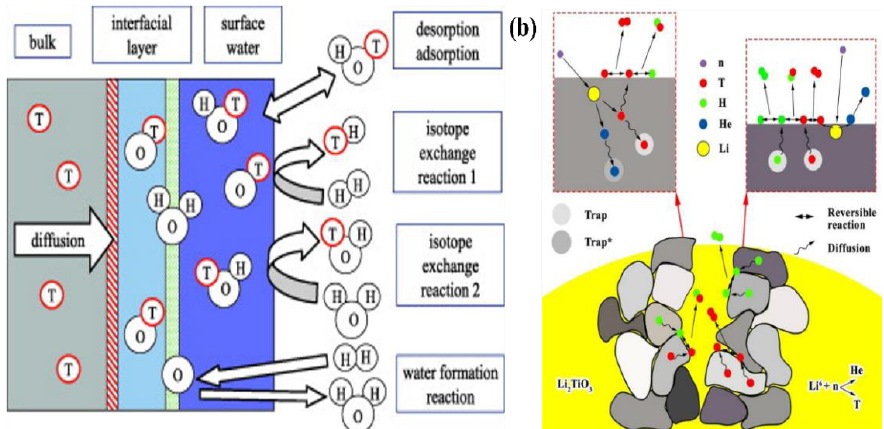
Figure 5. ( a ) The tritium release model from solid breeder materials. Reprinted with permission from ref. [90]. ( b ) Experimental study on the precipitation mechanism of tritium in lithium ceramics by vacuum extraction. Reprinted with permission from ref. [91].